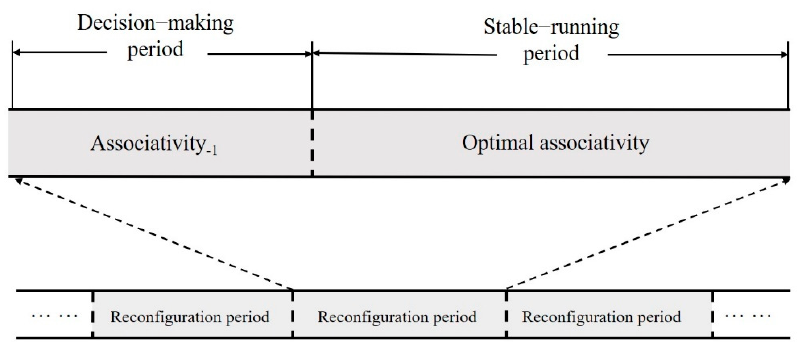
Figure 2. Division of application running times .